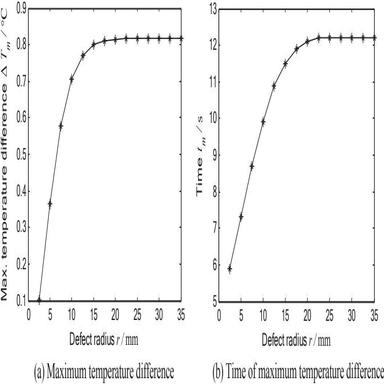
Defect informative parameters vs. defect radius (H = 10 mm, h = 4 mm).